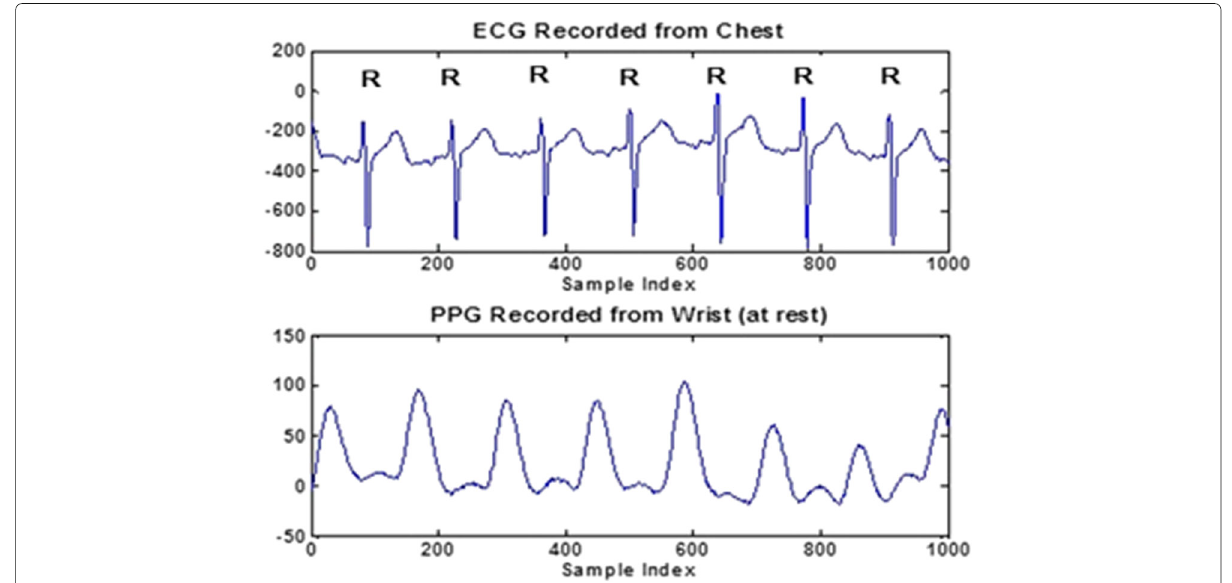
Fig. 1 Examples of ECG and PPG